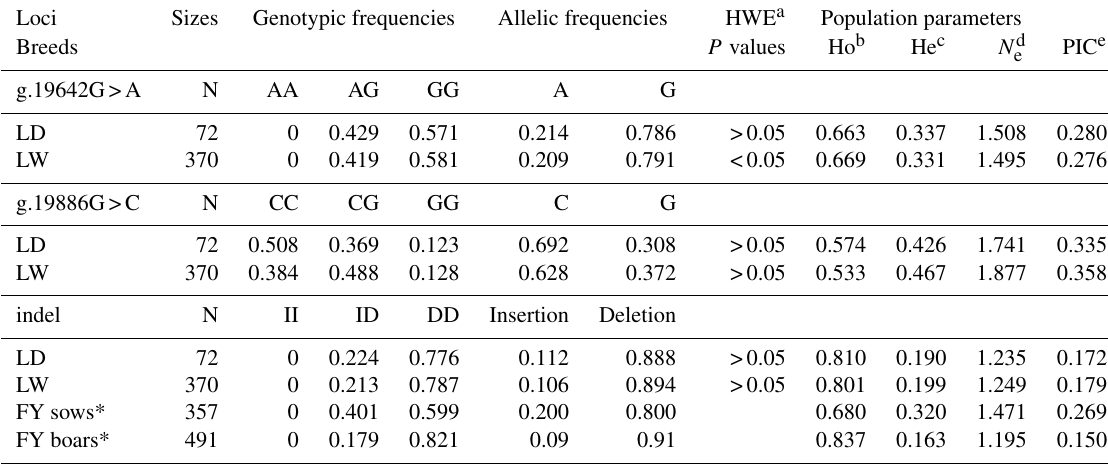
FY sows* 357 0 0.401 0.599